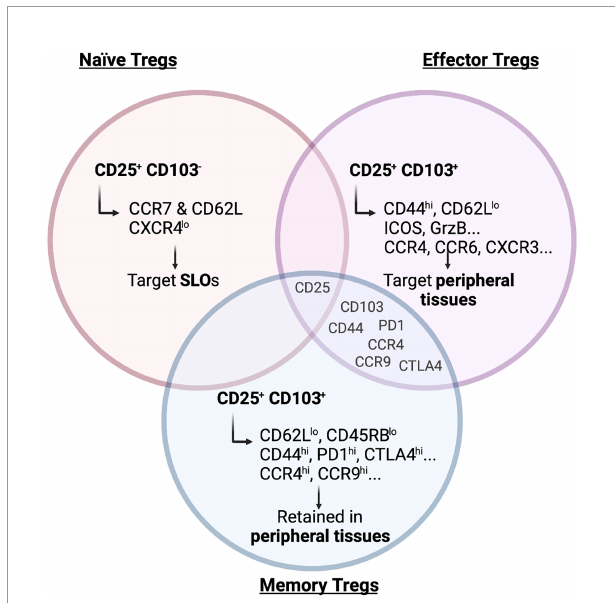
FIGURE 1 | Main markers of naïve, effector and memory Tregs. Surface receptors expressed on Tregs are crucial to determine their migration and residency in peripheral tissues. As depicted in the fi gure, markers of effector and memory Tregs are to a large degree shared but naïve Tregs show a clearly distinct marker pro fi le. Illustration created with